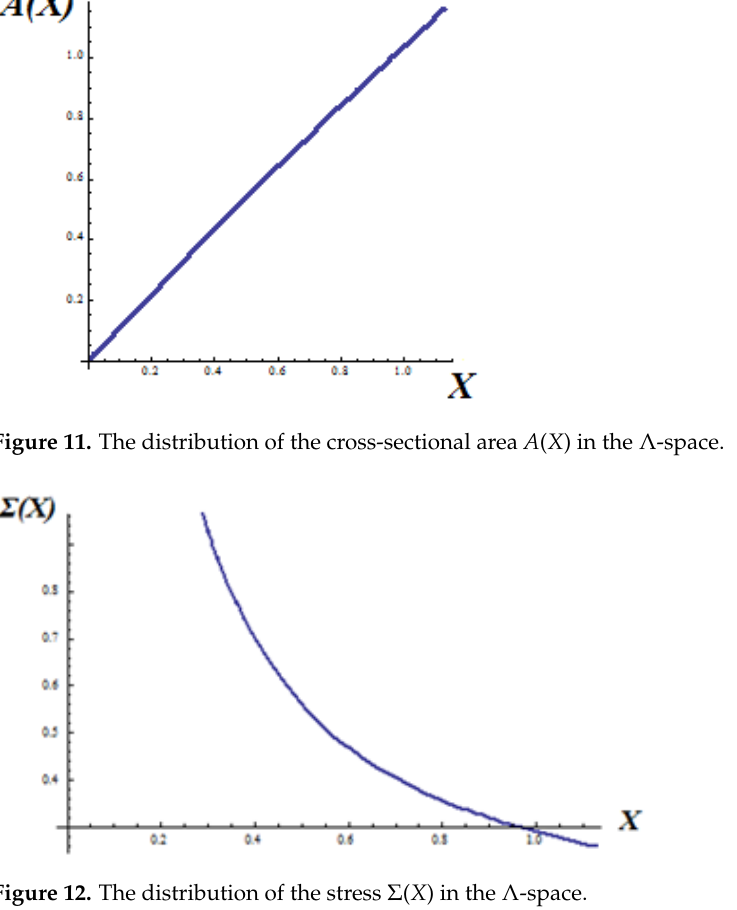
Figure 10. The (dimensionless) distribution of the cross-sectional area a ( x ).